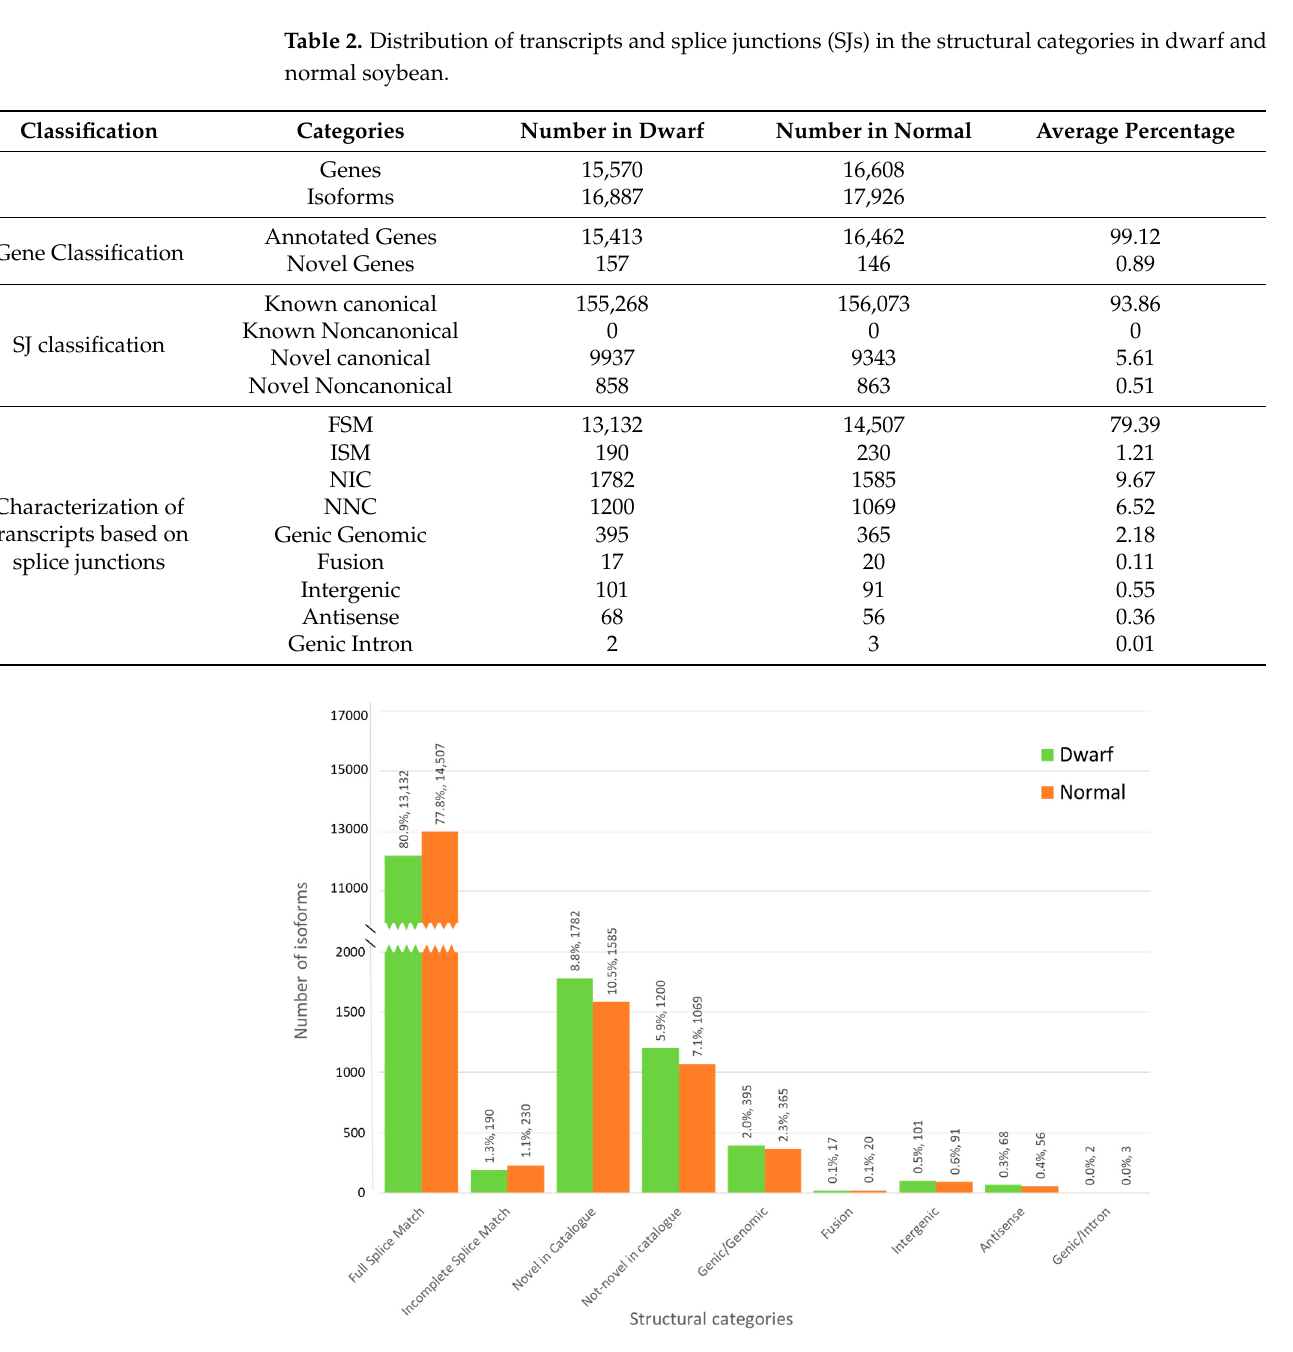
Figure 4. Alternative spliced isoform distribution across structural categories based on SQANTI in soybean. The maximum number of isoforms were under the FSM category whereas ~15% of the isoforms under newly formed from known genes were NIC and NNC. The novel categories were genic genomic, fusion, intergenic, antisense, and genic intron.